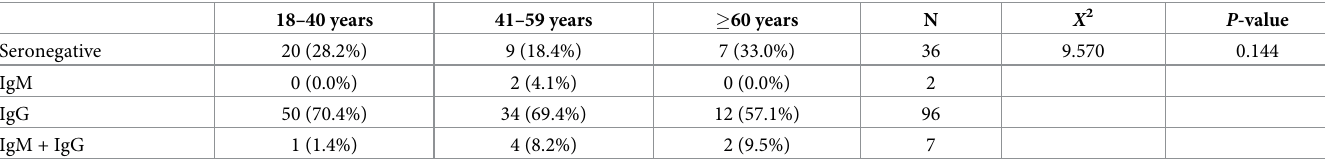
Table 4. Association between seropositivity and age groups.